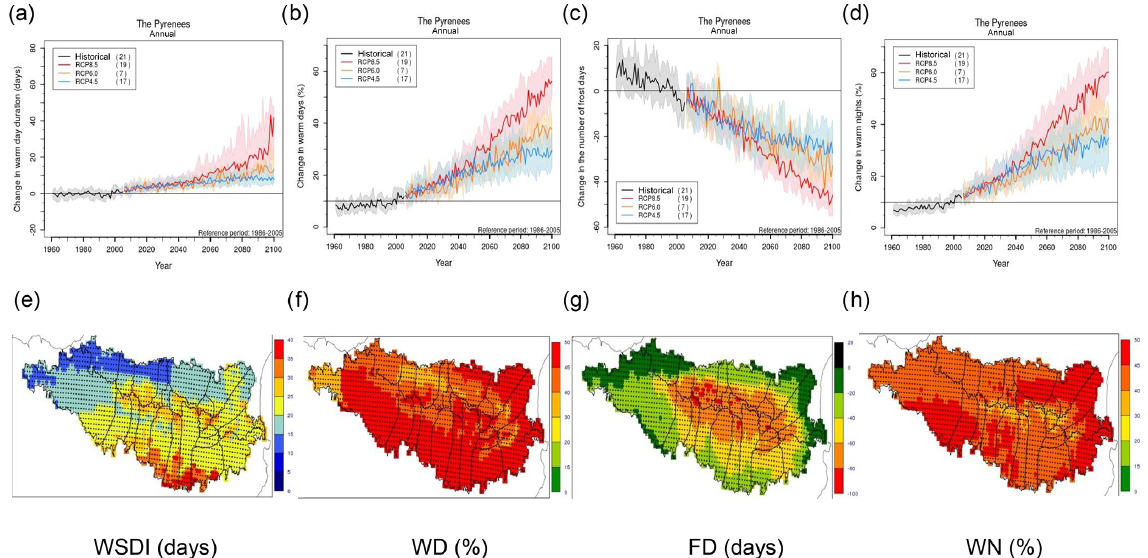
Figure 9. Evolution of some downscaled extreme temperature indexes computed at annual scale. (a) WSDI; (b) WD; (c) FD; and (d) WN. Maps of the median for the same extreme temperature indexes (e–h) and for RCP8.5 scenario and 2090 horizon. Stippled area reflects major signal ( q 50 > (( q 83 − q 17 ) /